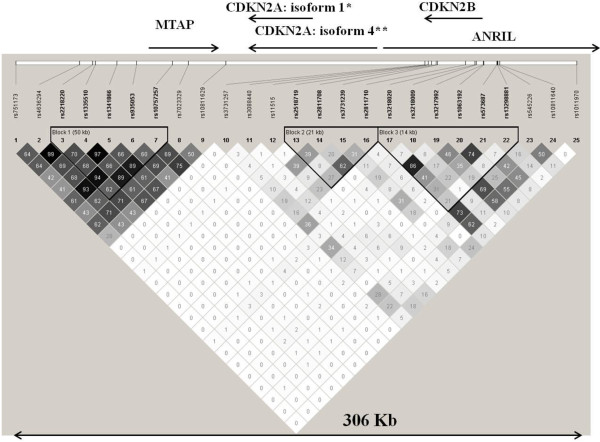
Linkage disequilibrium map of the genotyped polymorphisms on chromosome 9p21 in the Spanish population. *CDKN2A isoform 1 encodes p16INK4A ;**CDKN2A isoform 4 (CDKN2A/ARF) encodes p14ARF.